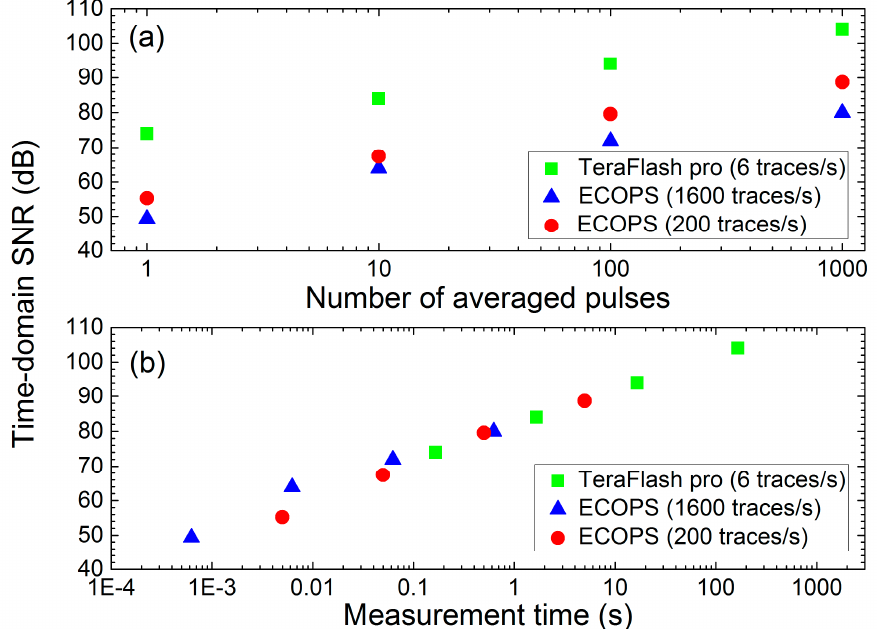
Figure 4. ( a ) TD-SNR as a function of the number of pulse-trace averages. Blue triangles: ECOPS at 1600 traces per second; red circles: ECOPS at 200 traces per second, green squares: TeraFlash pro. ( b ) Same data versus measurement time.